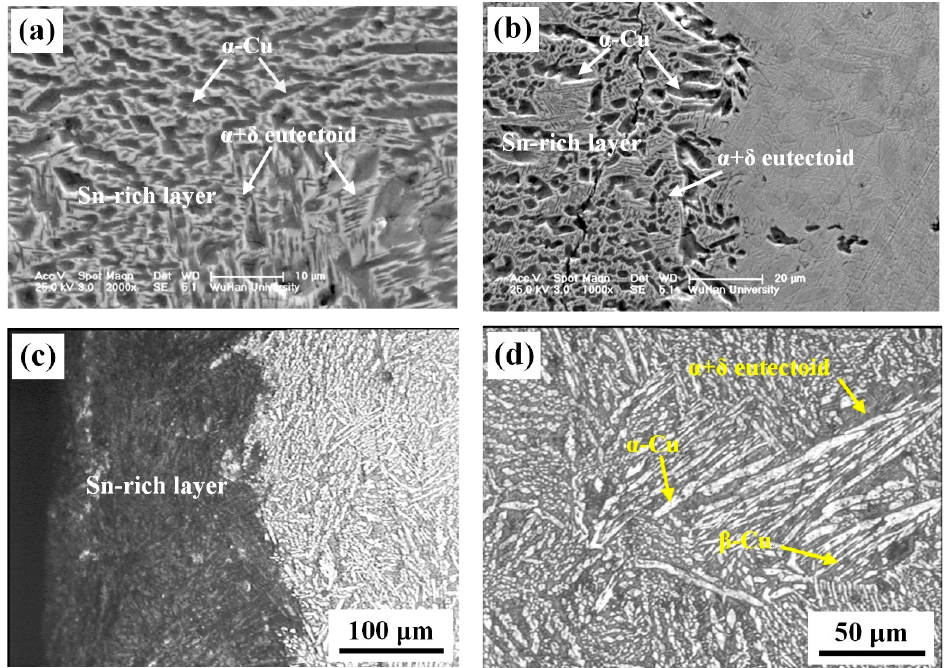
Figure 5. Cross-section microstructures of the sword: ( a ) SEM morphology of the Sn-rich layer; ( b ) SEM morphology of the interface between the Sn-rich layer and the body; ( c ) optical image of the interface between the Sn-rich layer and the body; ( d ) optical image of the body.